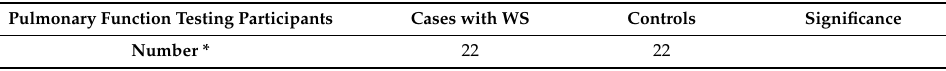
Table 1. Demographic data for study participants who underwent Pulmonary Function Testing